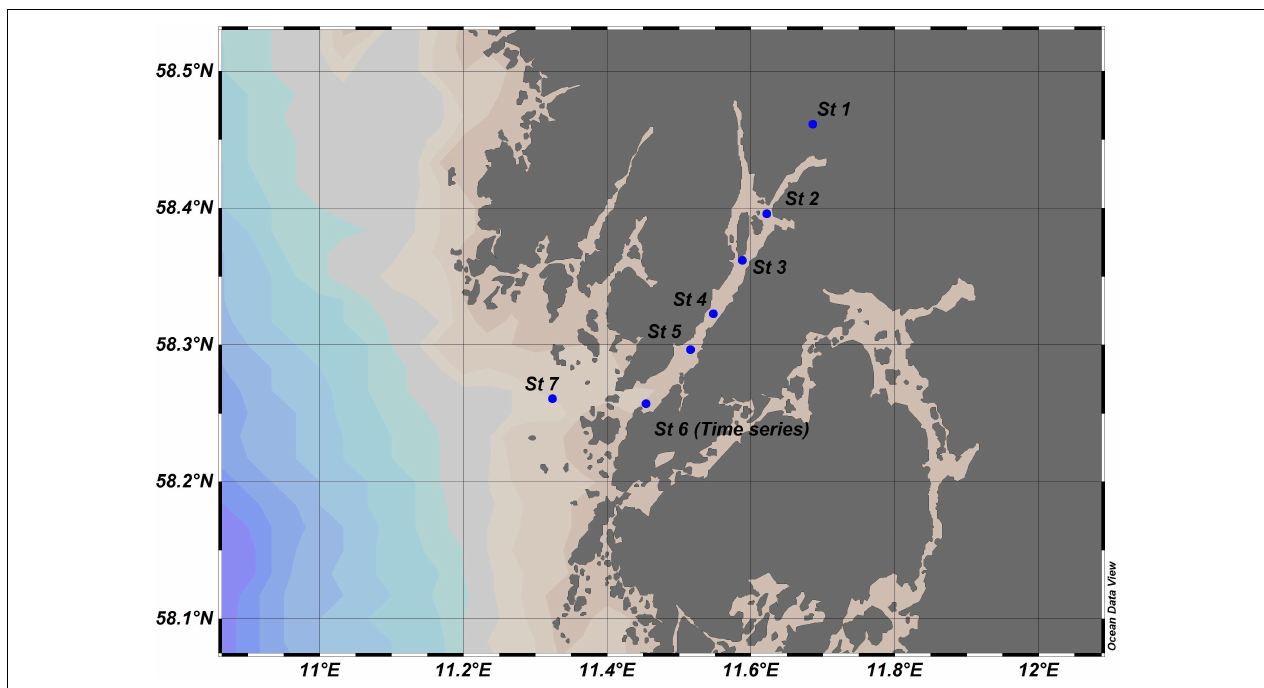
FIGURE 1 | Map of the sampling locations in the Gullmar Fjord (St. 1–St. 7). The 13-month time series in 2016–2017 occurred in the mouth of the fjord (St. 6). The two transects that sampled the multiple depths over the water column occurred in July (KB1707) and September (KB1709) in 2017 at seven stations along the fjord with St. 1 positioned in the Örekilsälven river and St. 7 positioned at the entry to the Skagerrak